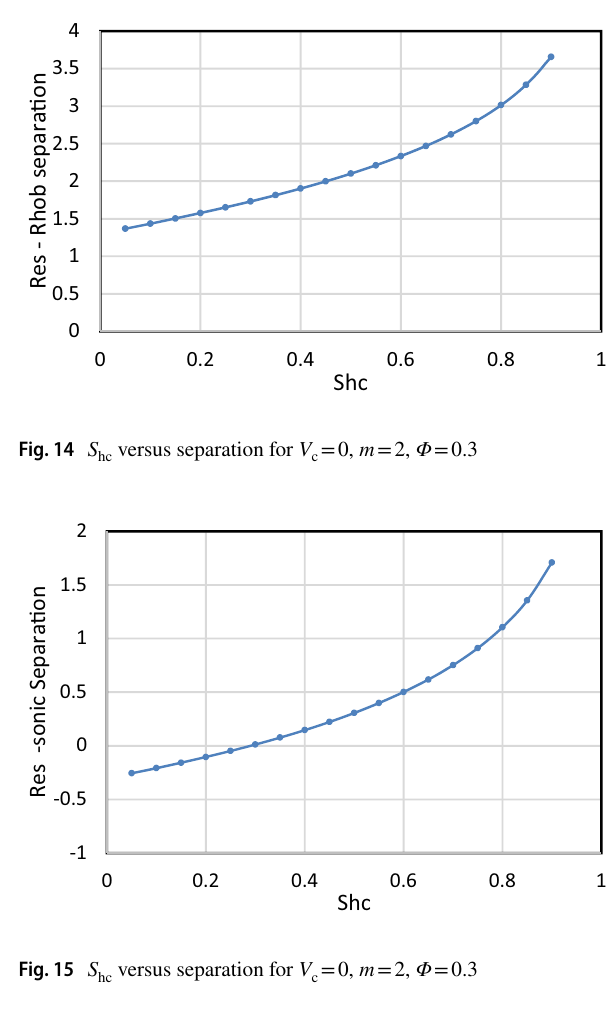
V m = 2, Φ = 0.3 c = 0,